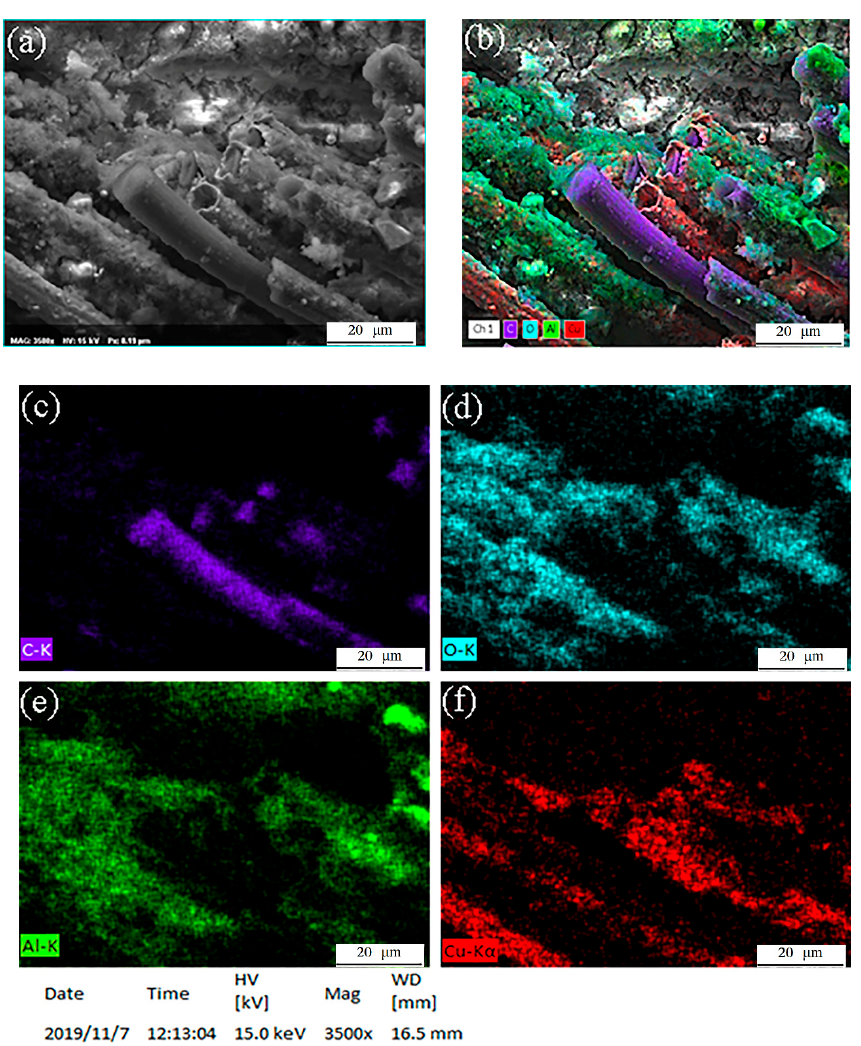
Figure 9. XPS spectra of the Cu coated braided carbon fiber rope: ( a ) survey XPS spectra; ( b ) Cu2p spectra.